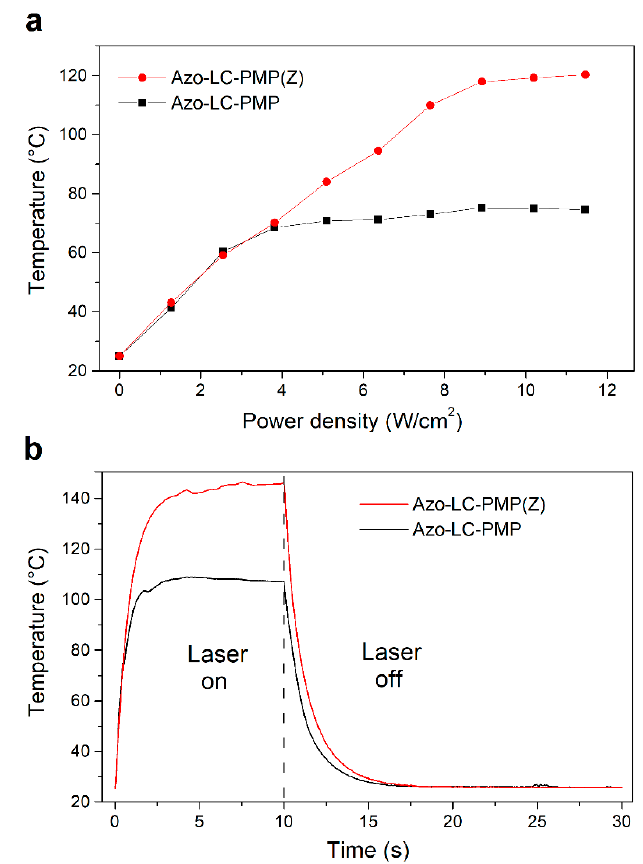
Figure 12. Thermographic measurements of the undoped (black color) and doped (red color) PMP film: ( a ) temperature at the equilibrium condition versus the power density of the laser irradiation, ( b ) temporal trend of the temperature during and after laser irradiation with a power density of 11.5 W/cm 2